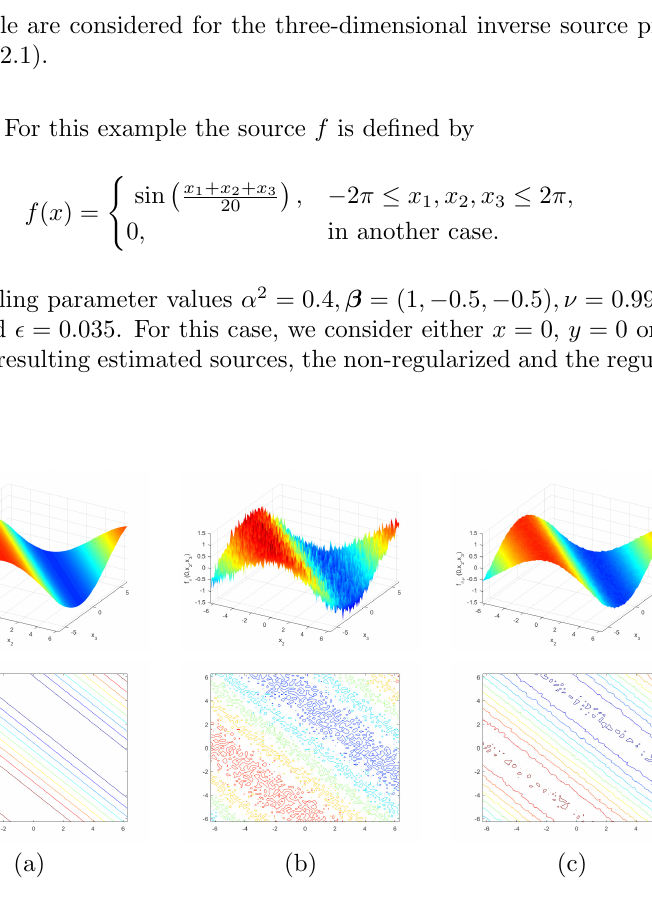
Figure 5. Sources for Example 5: original (a), unregularized (b) and regularized (c) for x = 0 assuming α 2 = 0 . 4 , β = (1 , − 0 . 5 , − 0 . 5) ,ν = 0 . 997 ,t 0 = 3 ,p = 3 and (cid:15) = 0 . 035.